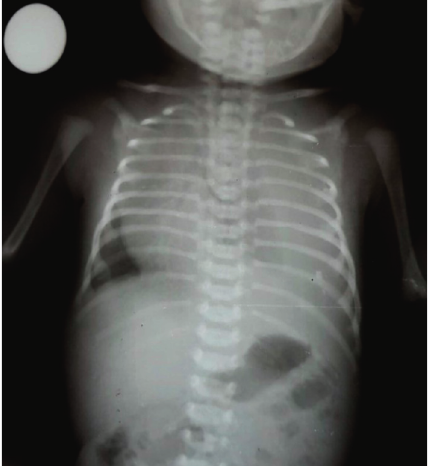
Figure 2: Left-sided pleural effusion of case